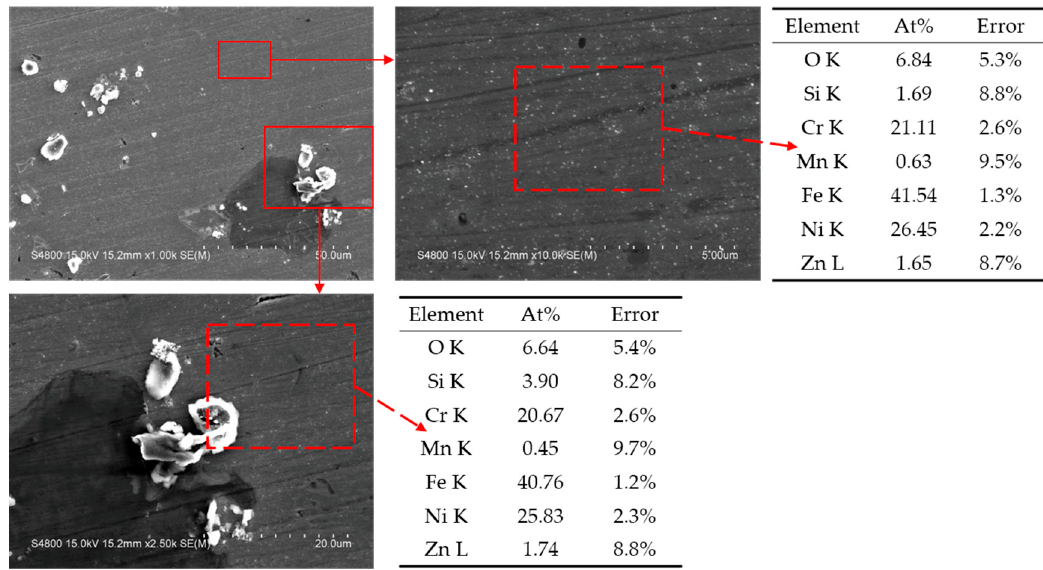
Figure 11. SEM images and the corresponding composition analysis of the passive film formed on In800 with the blank treatment.